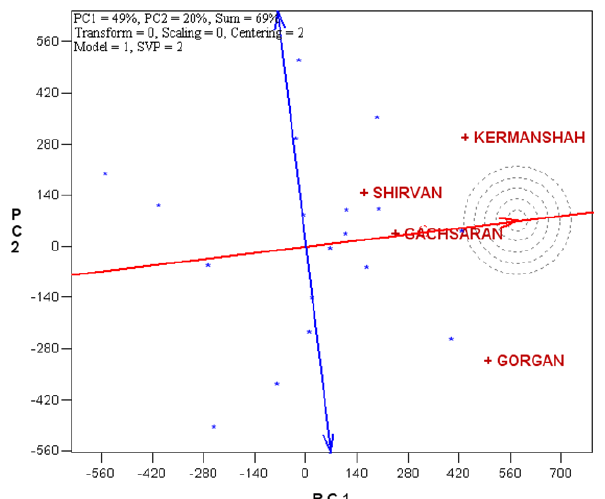
Fig. 6. GGE biplot of ideal location and comparison of the loca- tion with the ideal